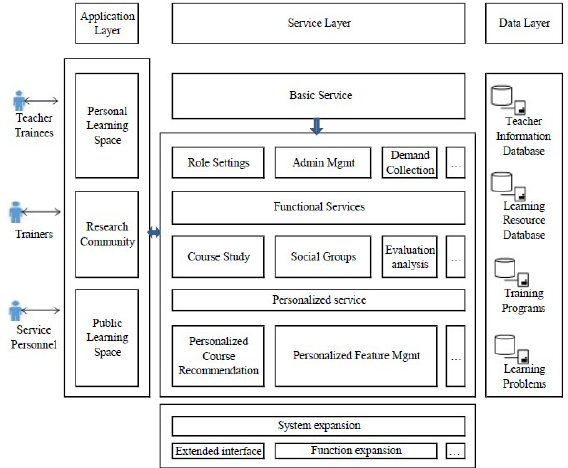
Figure 1. The Overall Framework of the Maker Teacher Mobile Training